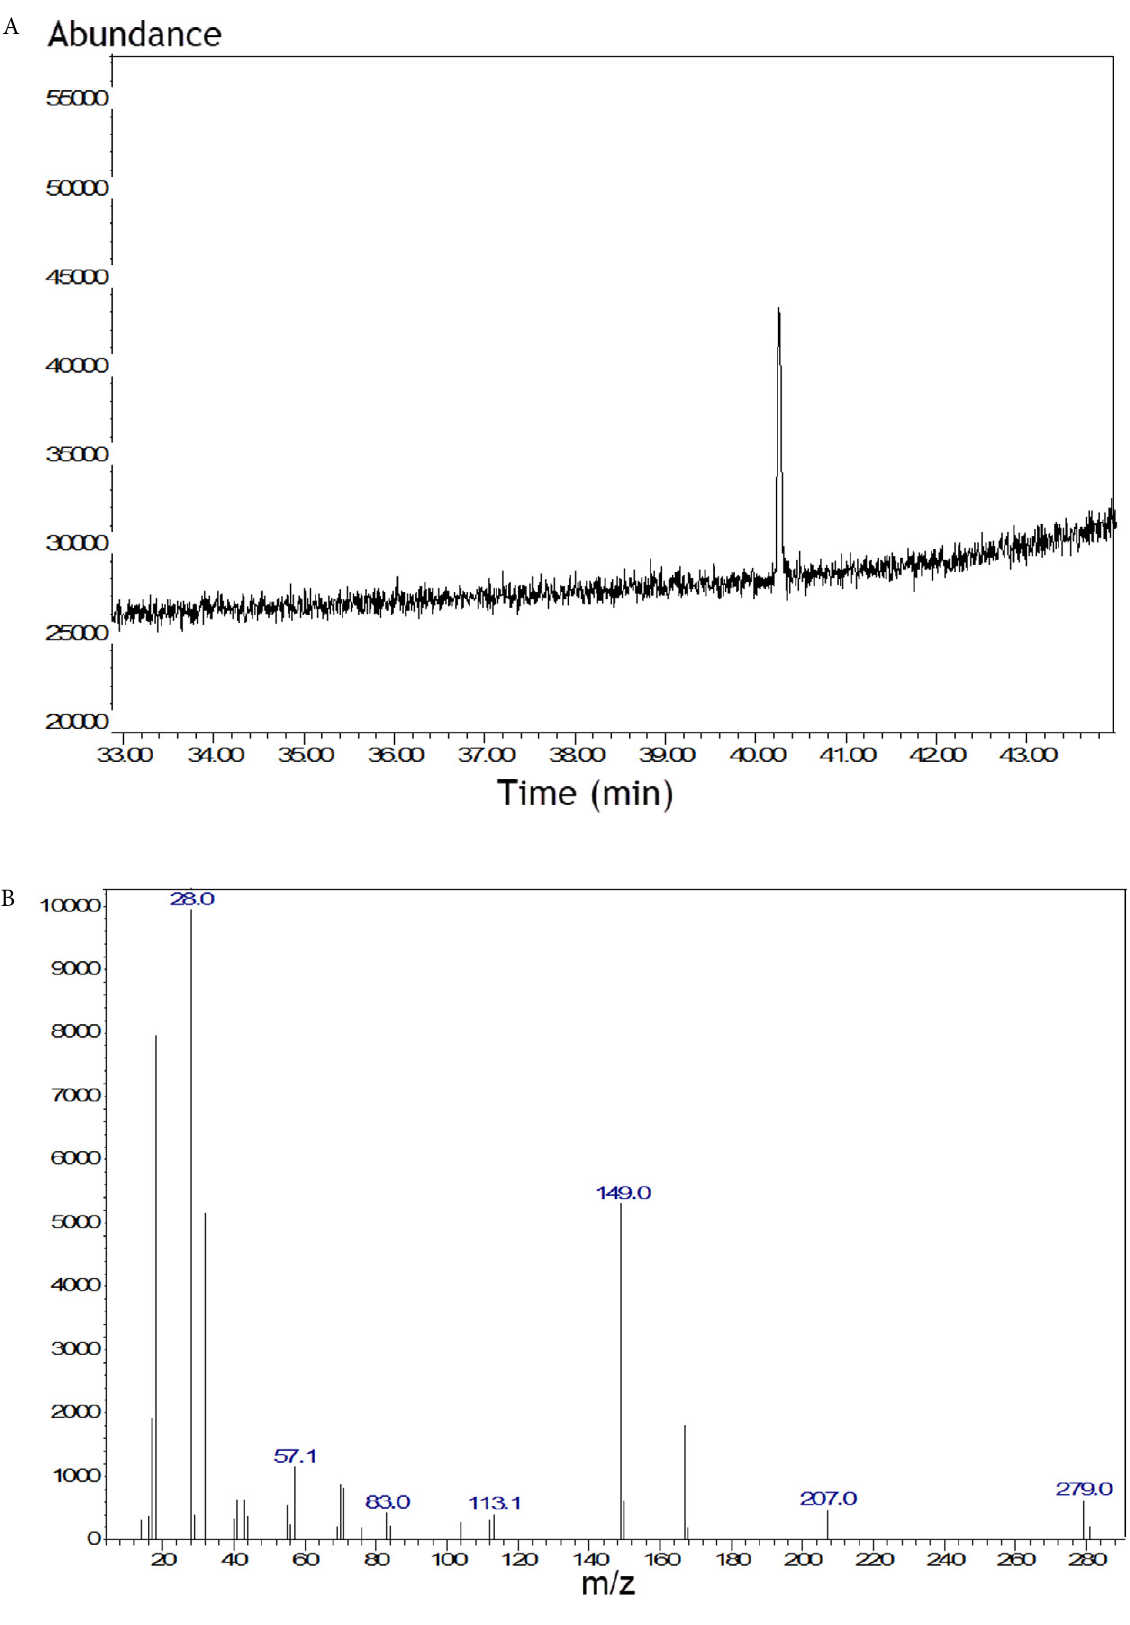
Figure 8. Total ion chromatogram (A) and GC/MS spectra (B) of compound